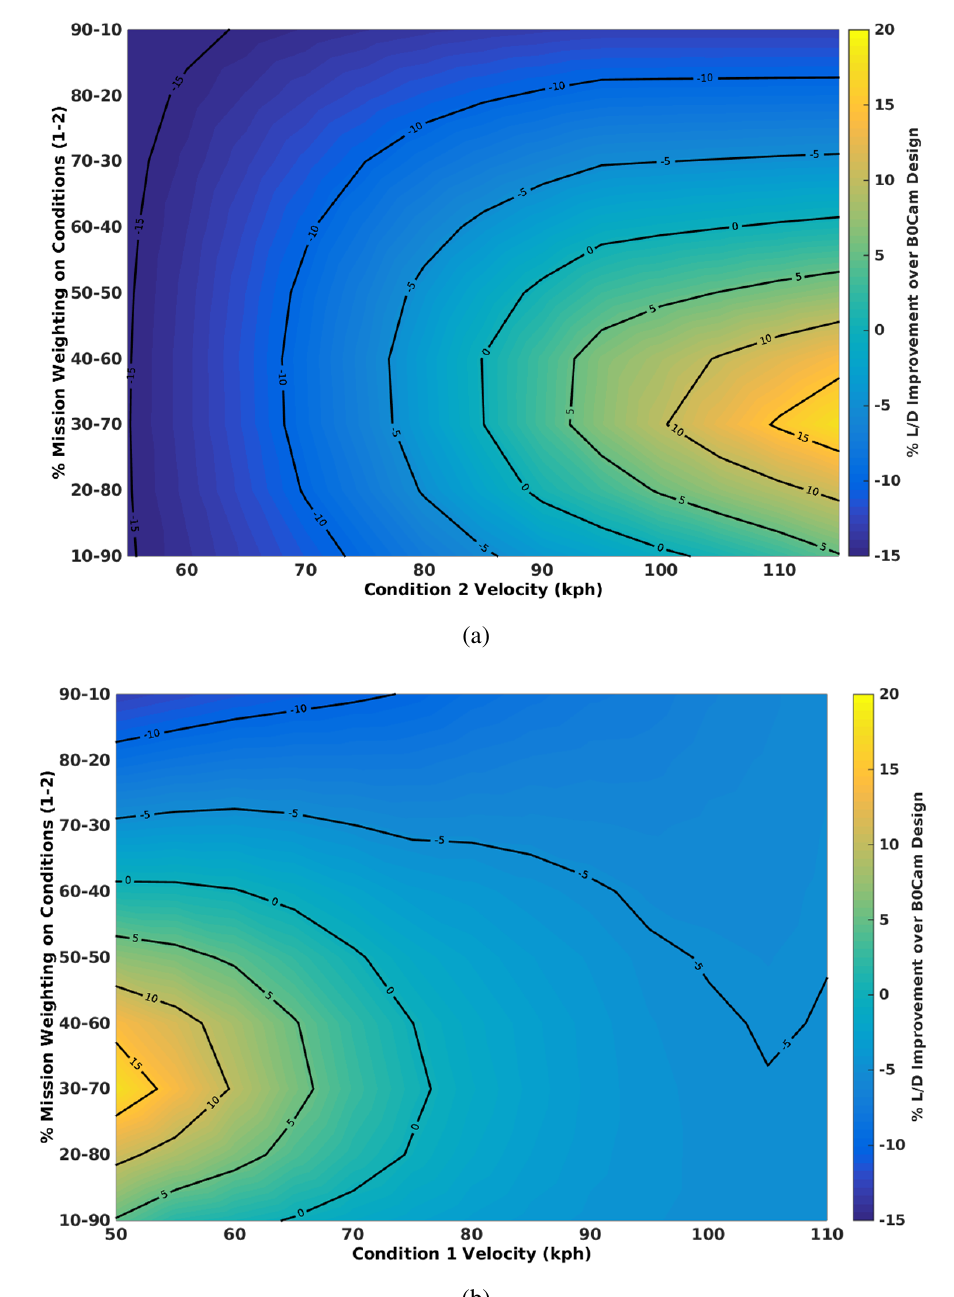
Figure 13. The effect of mission weighting on aerodynamic efficiency for optimum span with no camber over variable speed ranges normalised to the baseline camber design. ( a ) Aerodynamic efficiency for low speed fixed at 50 kph; ( b ) aerodynamic efficiency for high speed fixed at 115